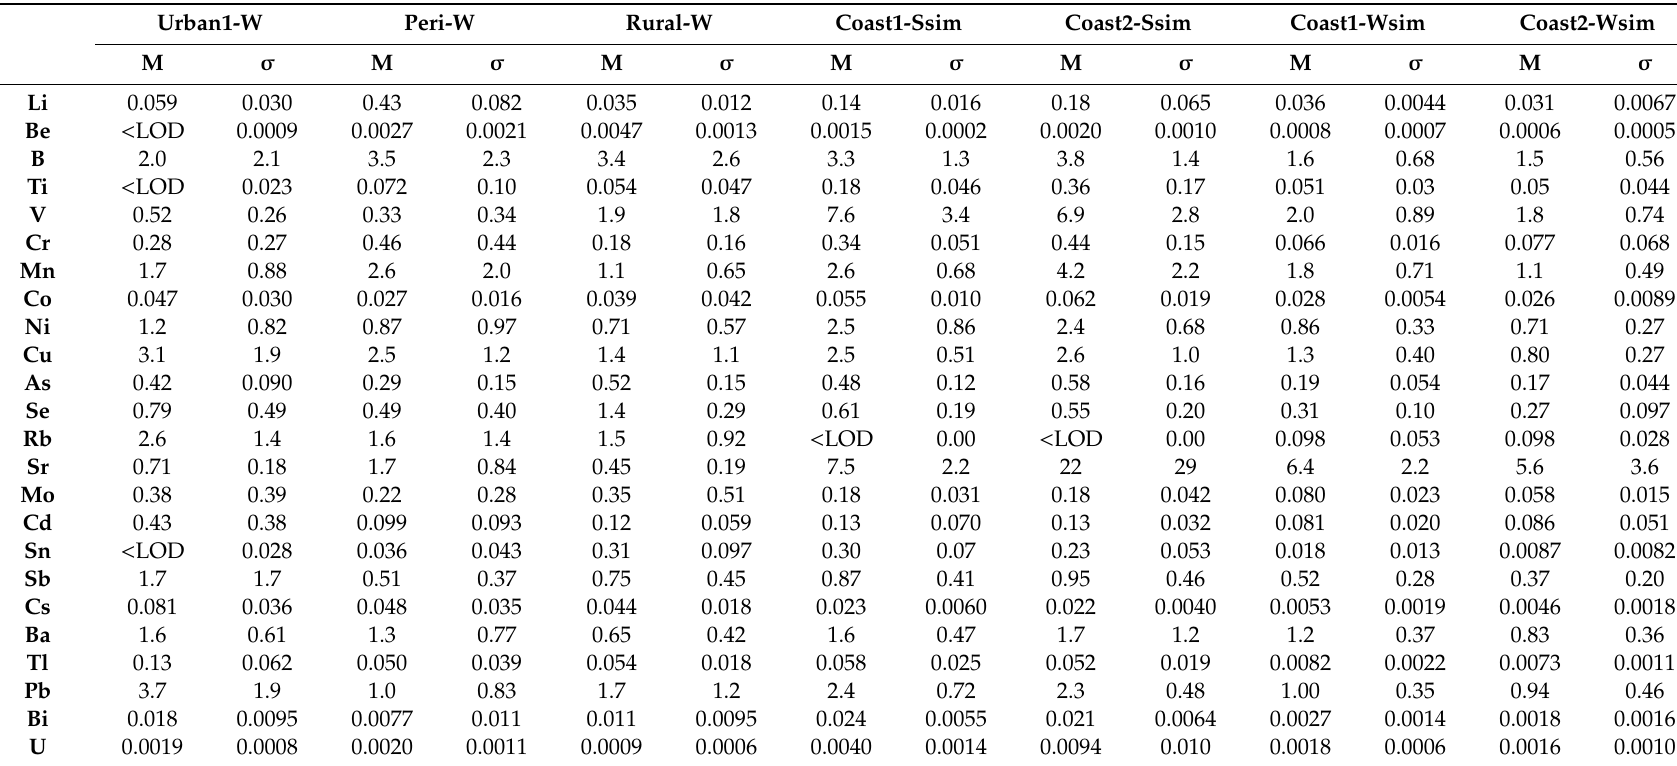
Table 6. Average mass concentrations (M) and standard deviations ( σ ) (in ng / m 3 ) of the extracted micro- and trace-components measured outdoors. * < LOD indicates a value below the limit of